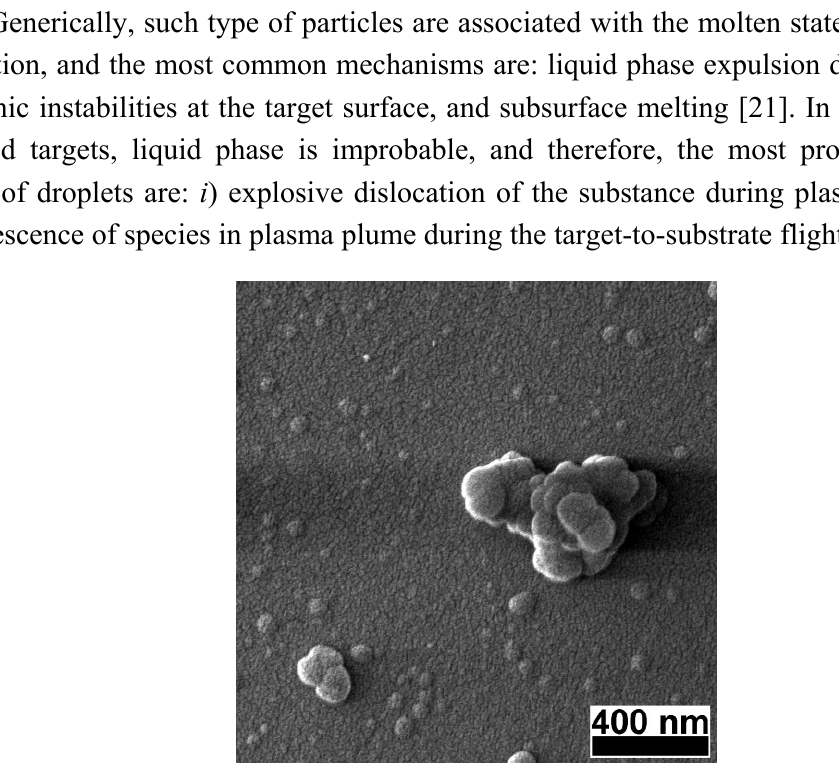
Figure 2. High magnification SEM micrograph of a pulsed laser deposition (PLD) carbon thin film deposited in vacuum on a buffered quartz